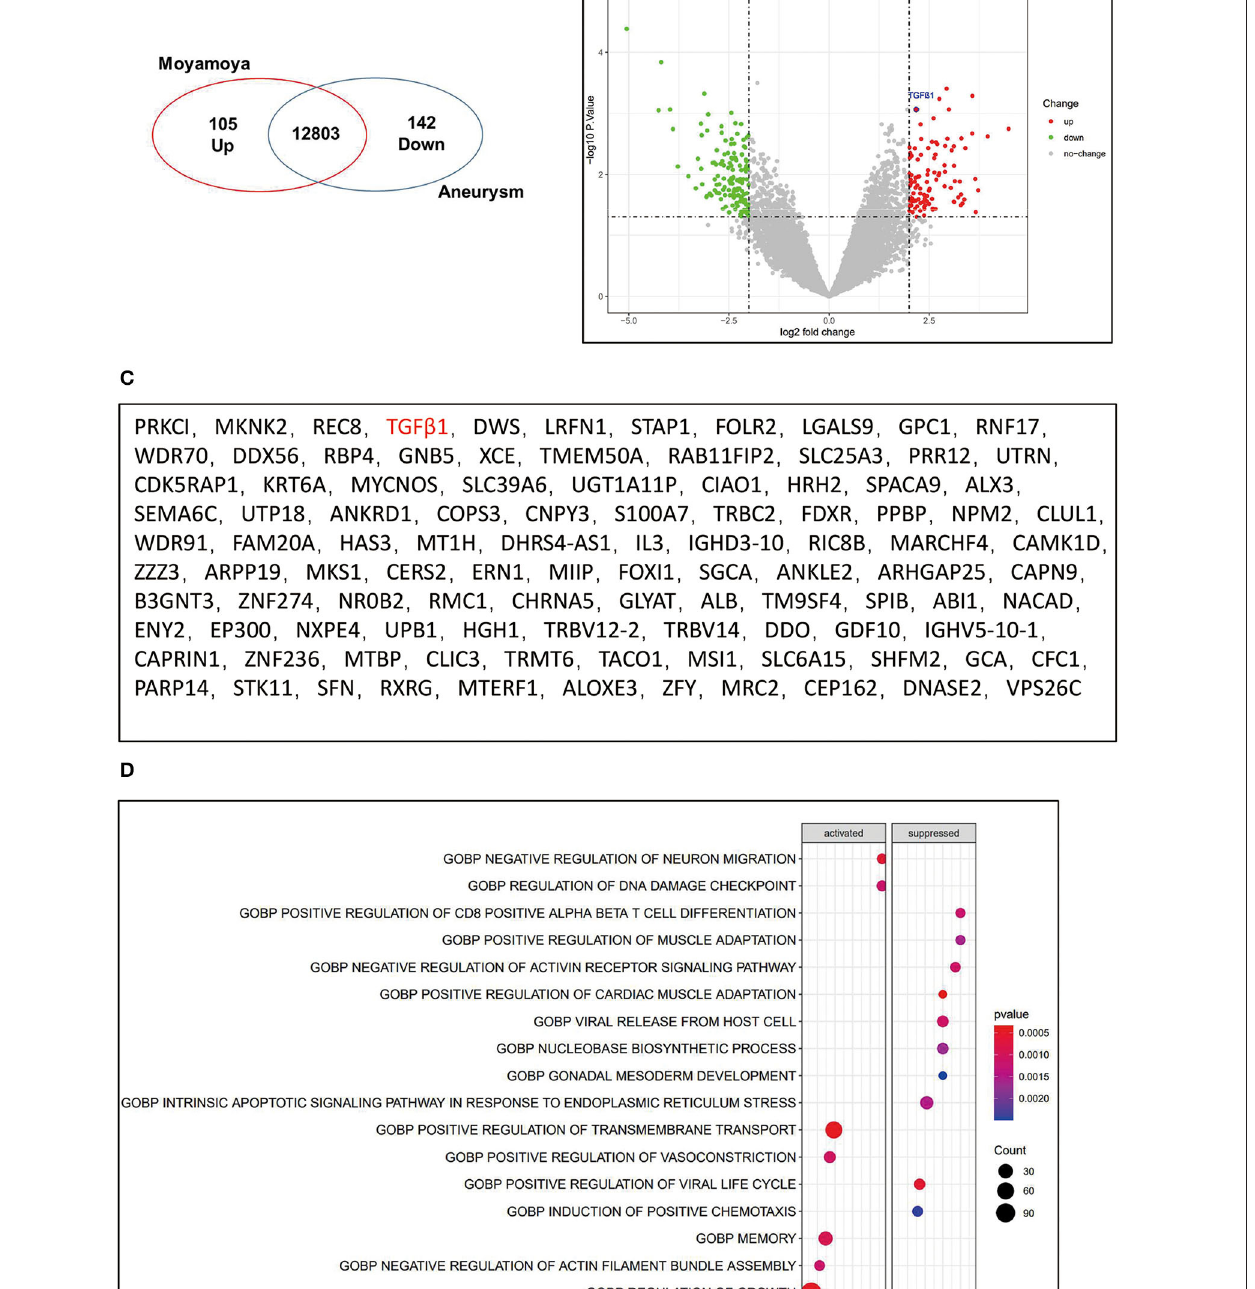
Frontiers in Neurology | www.frontiersin.org